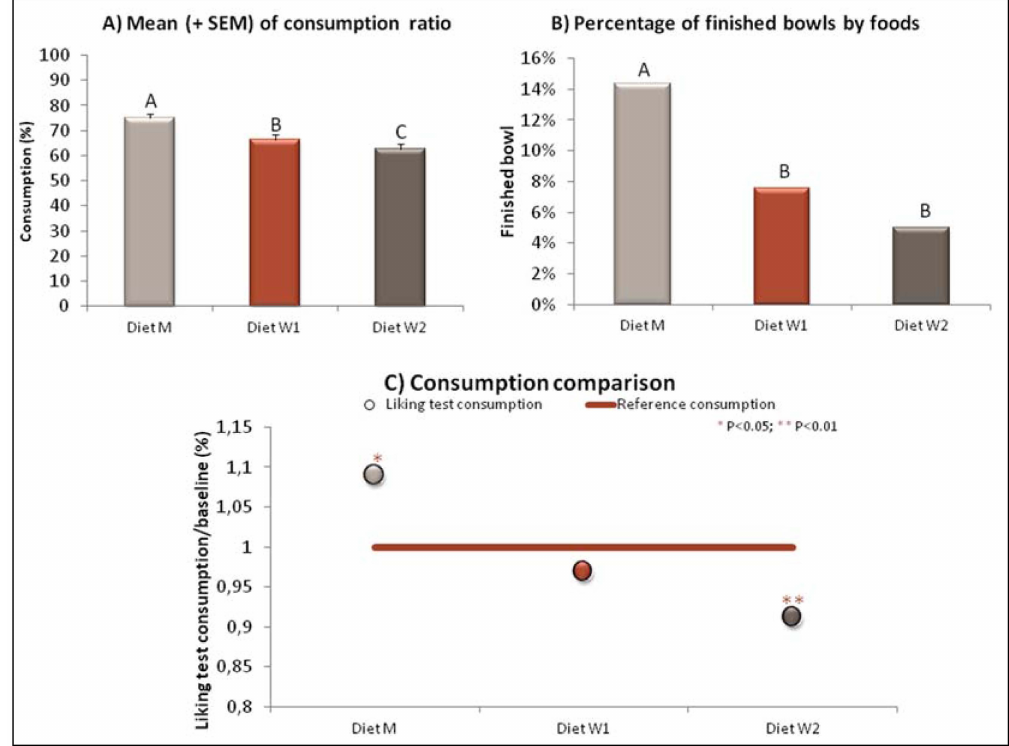
Figure 3. Evaluation of diets M, W1 and W2 by a Liking test conducted on an expert panel ( n = 38, Panelis) ( A ) consumption ratio, ( B ) finished bowls and ( C ) consumption